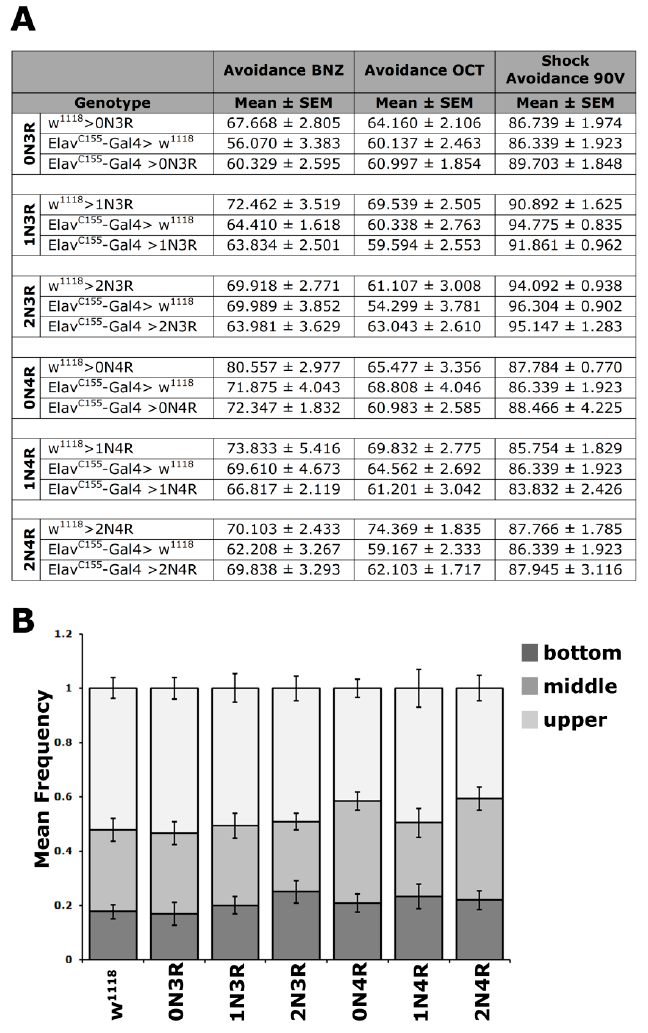
Figure 4. Conditioning stimulus perception and mobility is unaffected by hTau isoform accumulation. ( A ) Odor and electric footshock avoidance of animals accumulating pan-neuronally the indicated hTau isoforms compared with driver and transgene heterozygotes. The means ± SEM are shown for n ≥ 6 for all genotypes. ( B ) Negative geotaxis (climbing) of flies accumulating pan- neuronally for 5 days at 25 °C the indicated hTau isoforms compared with driver heterozygotes. The hTau isoform expressed is indicated below each bar. The means ± SEMs are shown for n ≥ 12 for all genotypes. Statistical details for both experiments are presented in Supplemental Table S4.